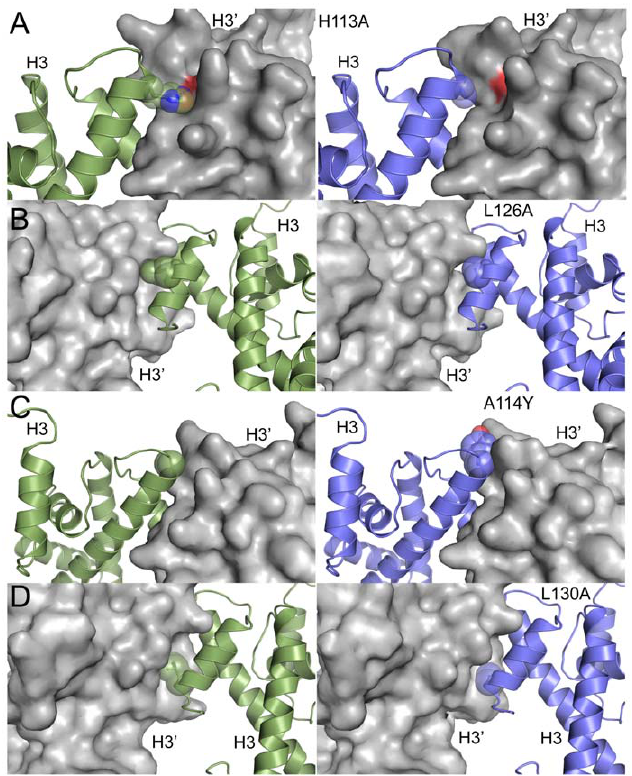
Figure 1. Inter-histone H3-H3 9 interface is destabilized by mutagenesis. Models for H3-H3 9 interface mutations that were tested in this study (right panels) are shown in comparison to the wild type interface (left panels). One of the binding partners is shown in surface representation, while the other is shown in cartoon representation with spheres depicting the mutated residues. H113A ( A ) results in the loss of a hydrogen bond with D123 across the interface, L126A ( B ), results in loss of hydrophobic interactions across the interface, A114Y ( C ) introduces bulky side-chain in the interface, and L130A ( D ) also results in loss of hydrophobic contacts across the interface. The structures were rendered using PyMOL (http://www. pymol.org).